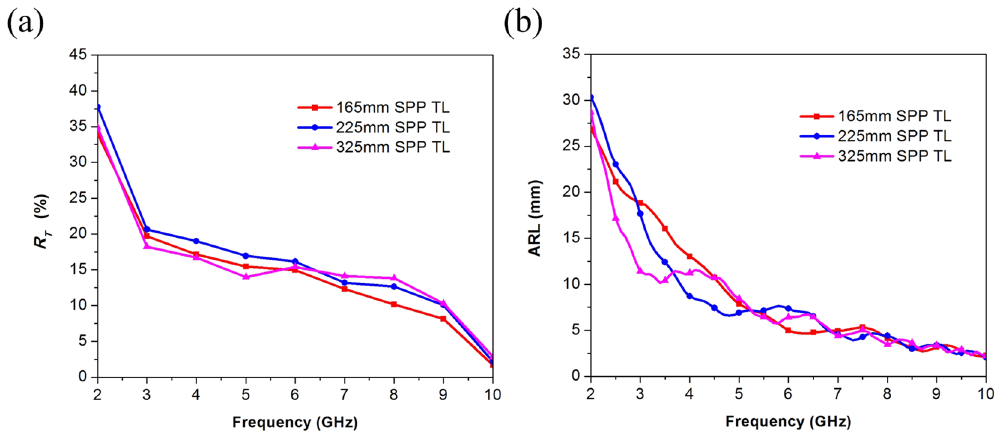
Figure 9. ( a ) Radiation loss from corrugated metallic strip. ( b ) Average radiation length